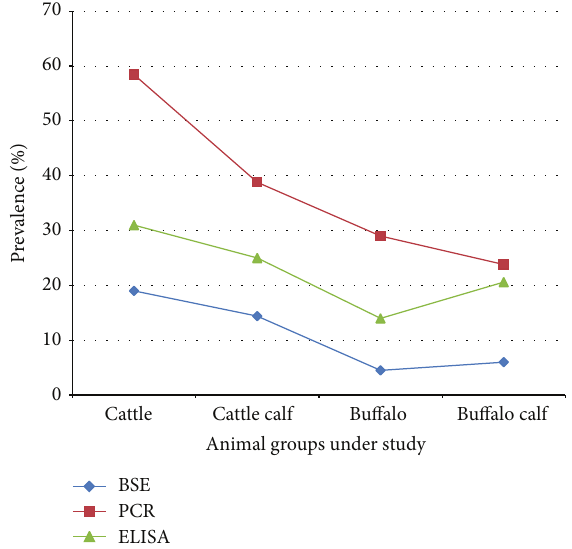
Figure 2: Incidence of A. marginale among different animal groups under study as diagnosed by Blood Smear Examination (BSE), Enzyme Linked Immunosorbent Assay (ELISA), and Polymerase Chain Reaction (PCR) revealing cattle as the most exposed